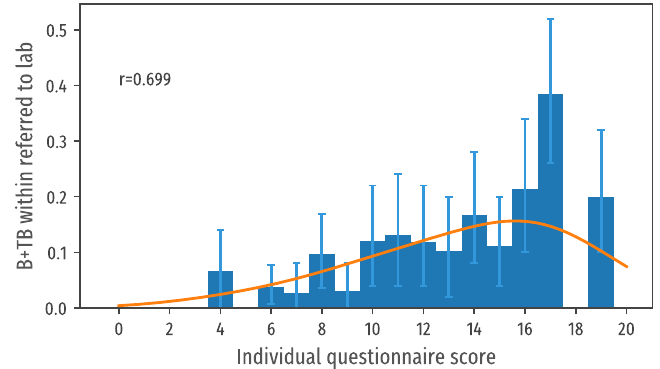
Figure 4. Proportion on laboratory confirmed TB cases per score class.